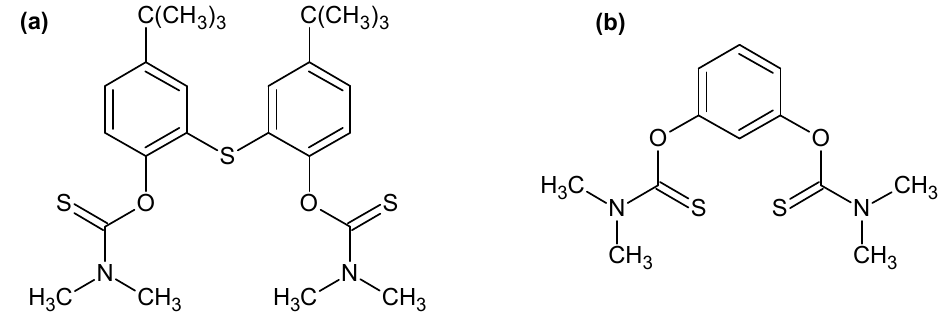
Figure 5. The structures of the best Pd(II) thiocarbamate extractants investigated by Yamada et al.: ( a ) 1,1 ′ -bis[(dimethylthiocarbamoyl)oxy]-2,2 ′ -thiobis[4- t -butylbenzene] [54]; ( b ) 1,3-bis(dimethylthiocar bamoyloxy)benzene